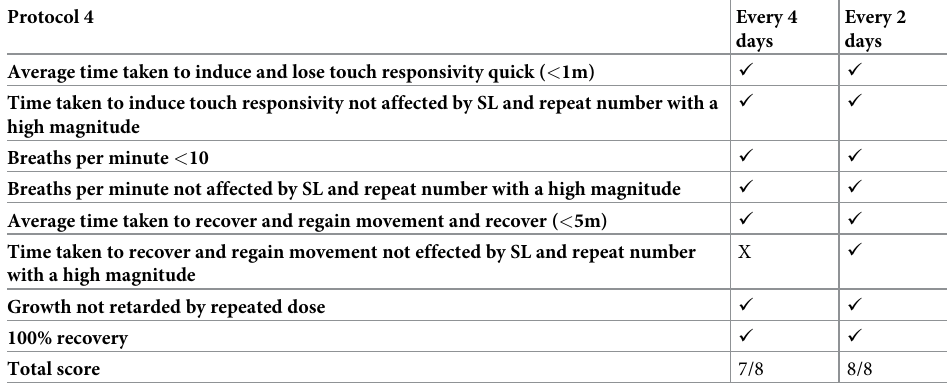
Every 2 days days ✓ ✓ X ✓